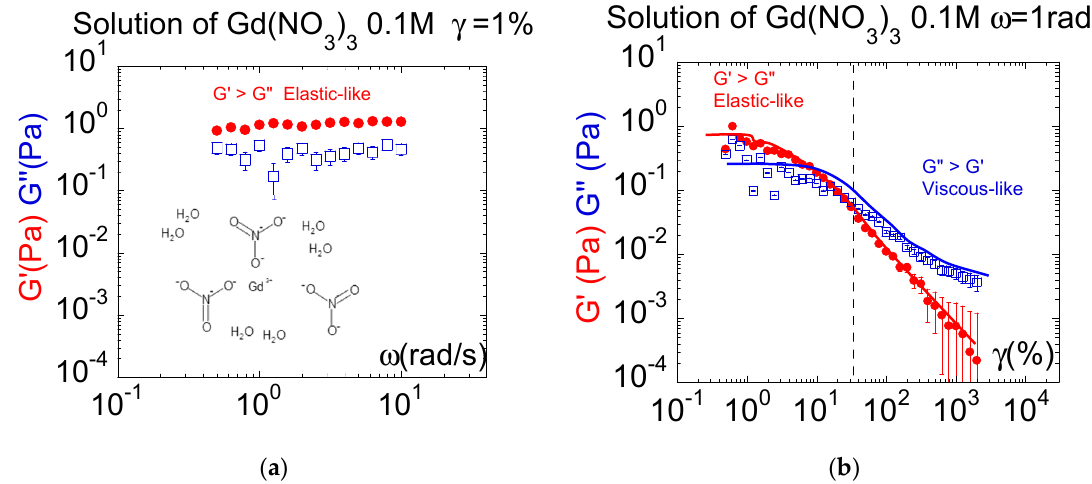
Figure 3. ( a ): Low-frequency elastic response exhibited by an aqueous solution of 0.1 M of Gd(NO 3 ) 3 versus frequency. The shear modulus G ′ is higher than the viscous modulus G ″ , indicating an elastic-like behavior. Room temperature measurements using total wetting conditions (Alumina substrate), sample thickness: 0.430 mm, shear strain: 1%, logarithmic scale. ( b ): Shear strain behavior displayed by the 0.1 M aqueous solution of Gd(NO3). The shear modulus G ′ , higher than the viscous modulus G ″ , vanishes with increasing strain, making the conventional viscous behavior appear. Measurements carried out at 0.430 mm thickness, 2 rad/s, room temperature using total wetting boundary conditions (alumina). The vertical dashed line indicates the transition between elastic and viscous regimes. The continuous lines are eye guides.